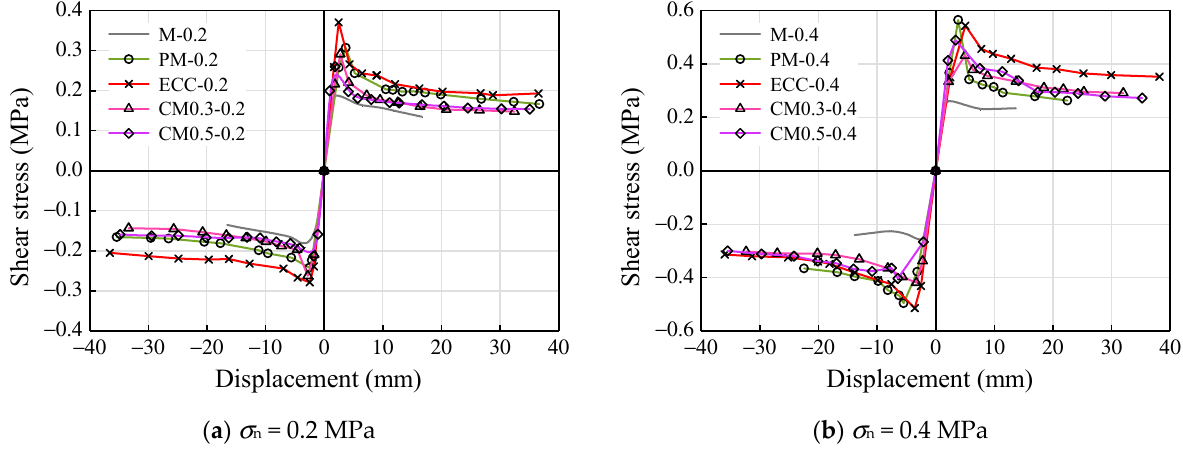
Figure 14. Shear stress–displacement responses: ( a ) σ n = 0.2 MPa and ( b ) σ n = 0.4 MPa.